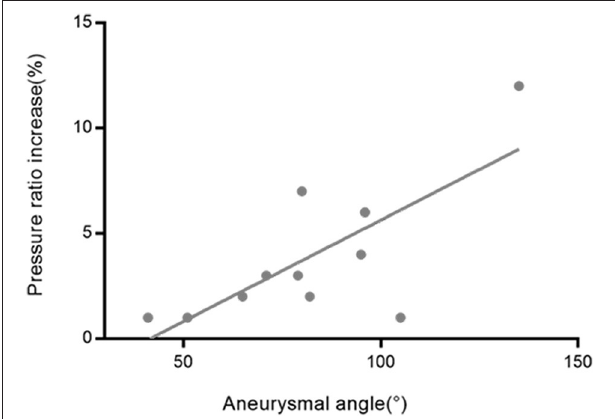
FIGURE 5 | The relationship between the aneurysmal angles and the pressure ratio increase rates in M2 + M3 segments after obliteration of the aneurysms. The correlation coefficient was r =